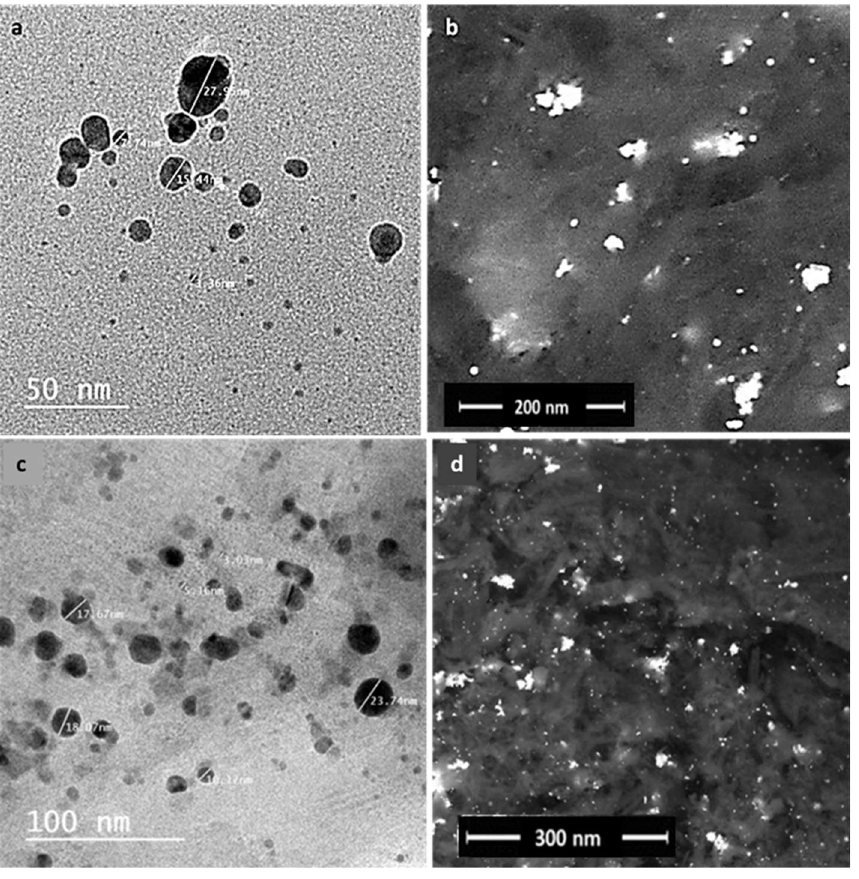
Figure 3. TEM micrographs of poly-dispersed-shaped AgNPs prepared with CE ( a ) and spherical- shaped AgNPs prepared with EE ( c ) and FESEM micrographs of the prepared AgNPs ( b , d ).